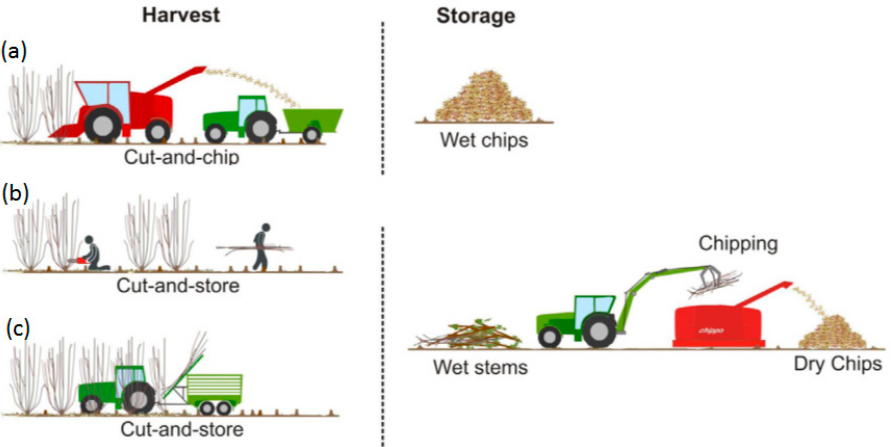
Figure 6. Schematic overview of the different harvesting methods for short-rotation woody crops. [97].